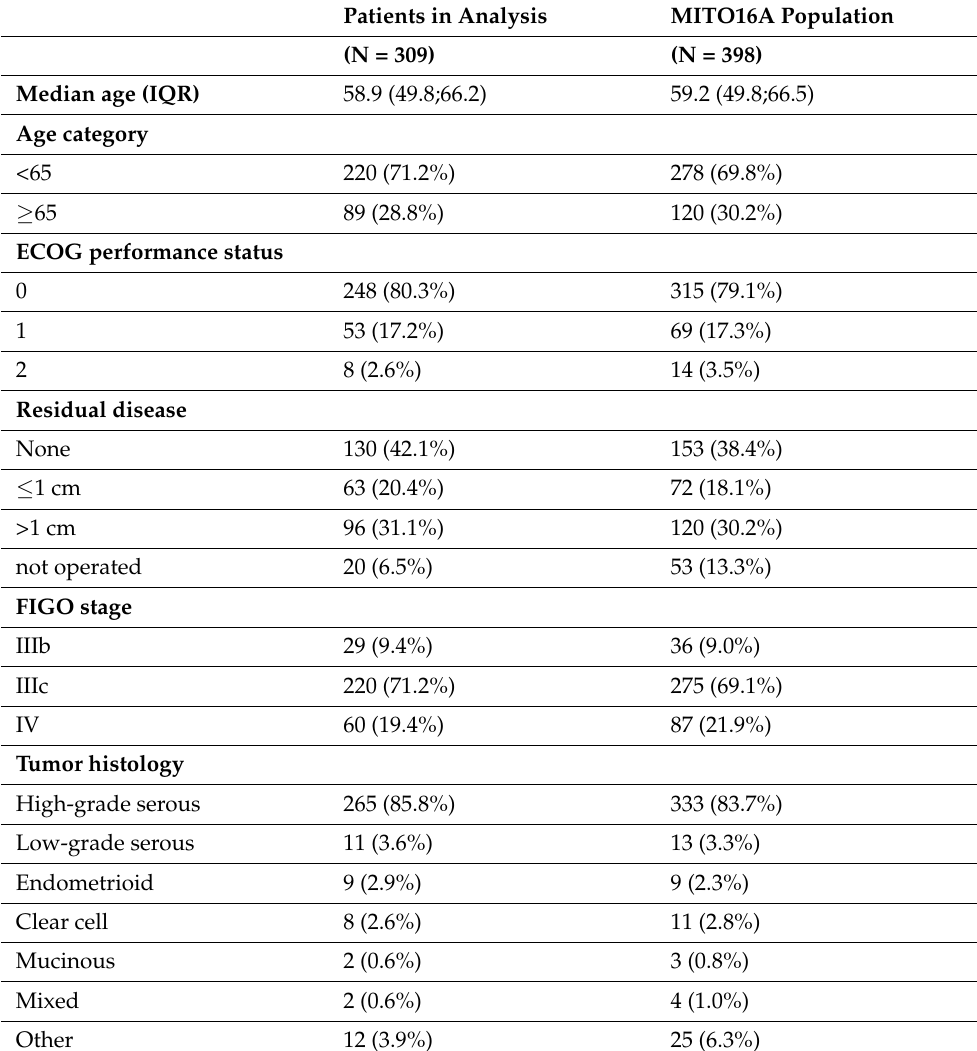
Table 1. Baseline characteristics of patients and disease of the cases analyzed as compared to the whole MITO16A